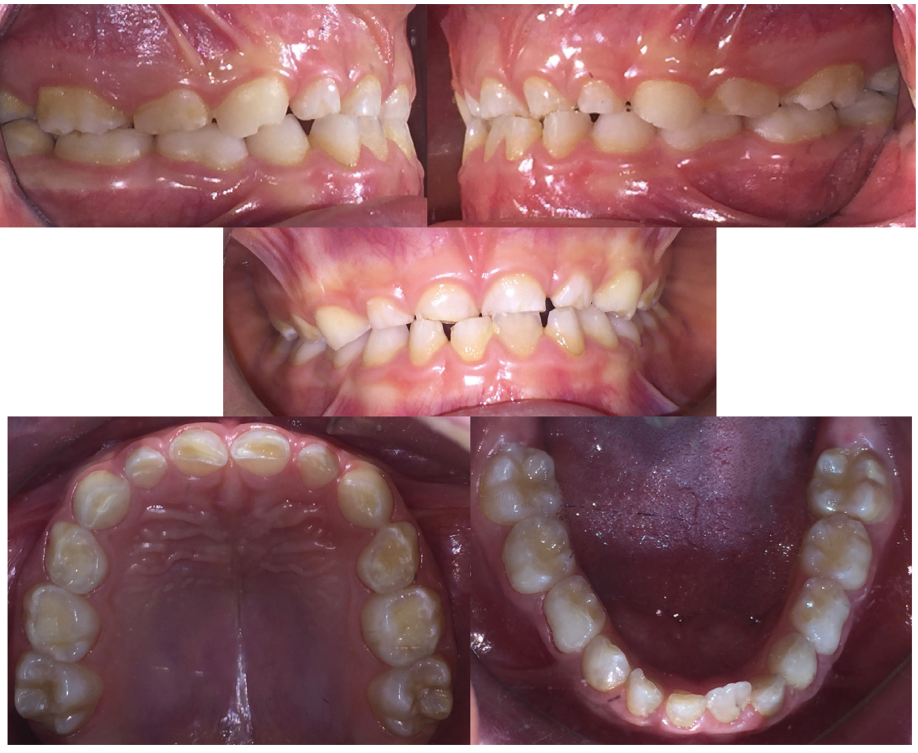
Figure 4: Case 1: intraoral photographs.